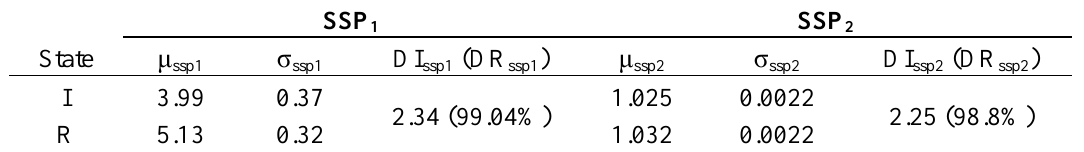
Table 4. Values of DR and DI after